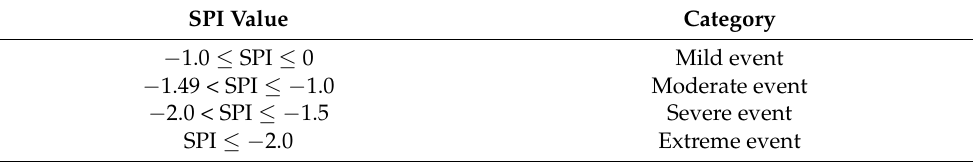
Figure 2. Boxplots of temperature and rainfall for all stations across South Africa (2000–2020): ( a ) temperature (°C); ( b ) rainfall (mm); ( ) mean; ( ____ ) median. Table 2. Classification of standard precipitation index (SPI) for drought